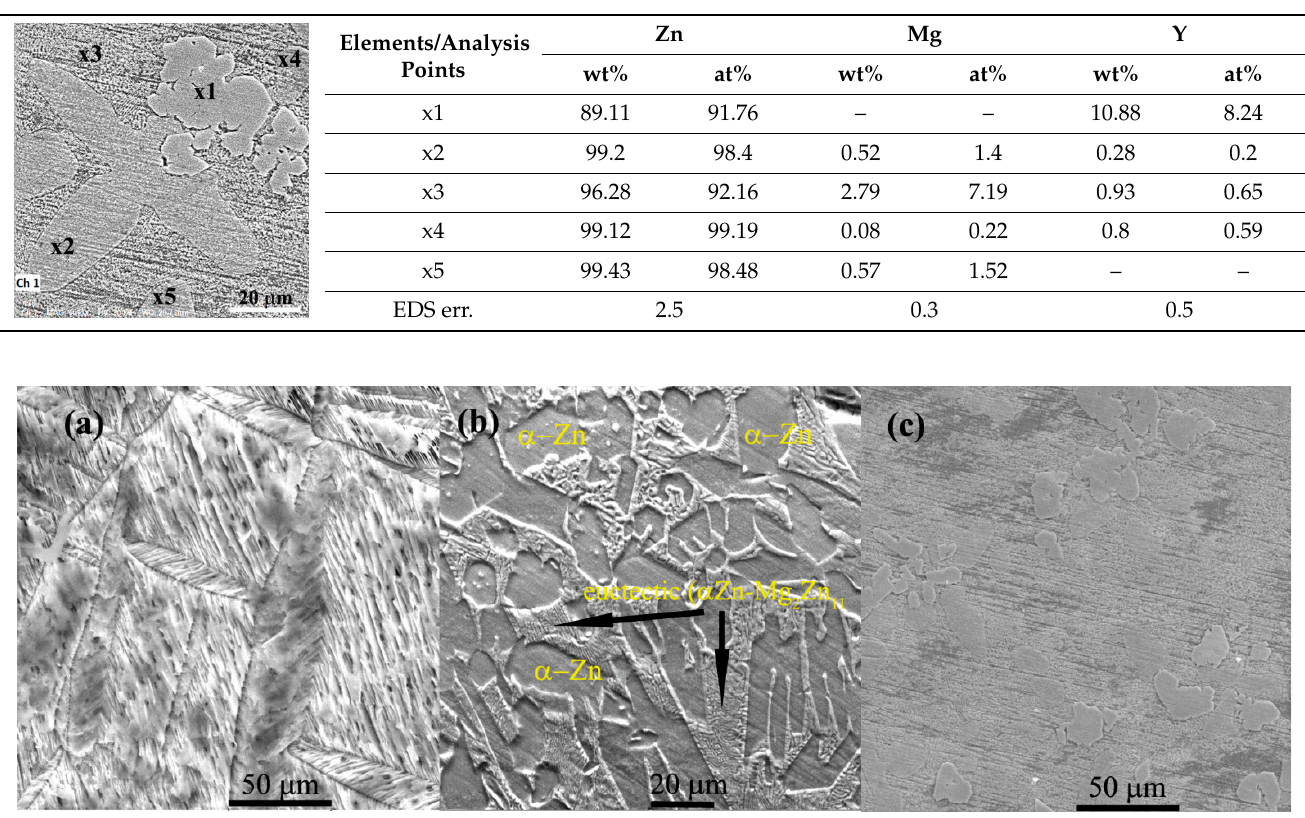
Figure 3. Structural aspects of the samples before corrosion tests ( a ) Zn, ( b ) ZnMg, and ( c ) ZnMgY.